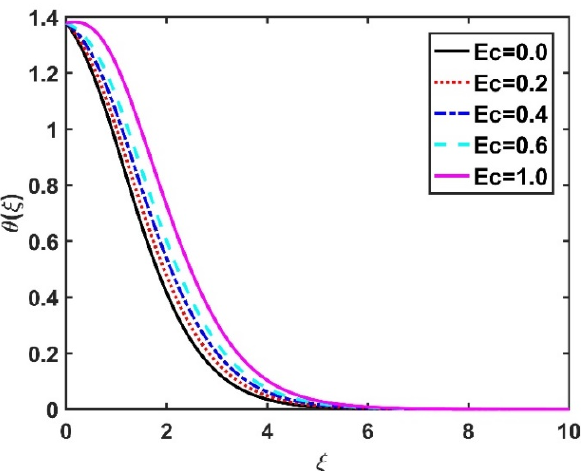
Figure 10. Impact of Ec on θ ( ξ )